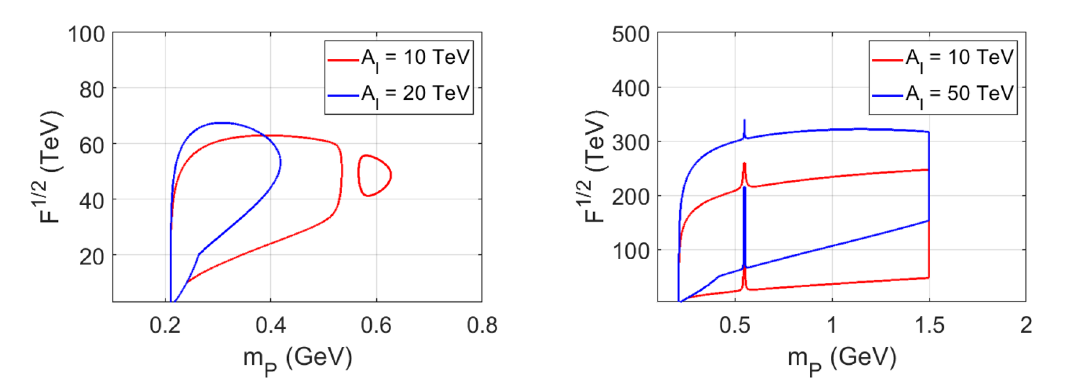
√ √ F < A l we set A l = F .